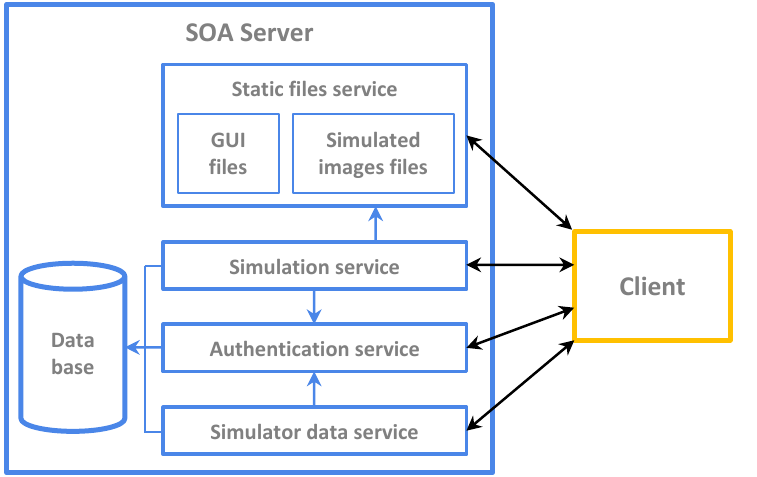
Figure 1. Service-oriented architecture (SOA)